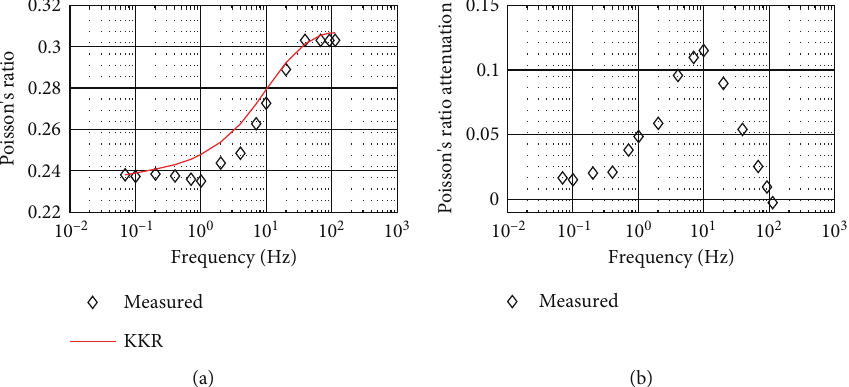
Figure 3: The frequency dependence of Poisson ’ s ratio and it associated attenuation of partially water-saturated Indiana limestone sample (from Sun et al.